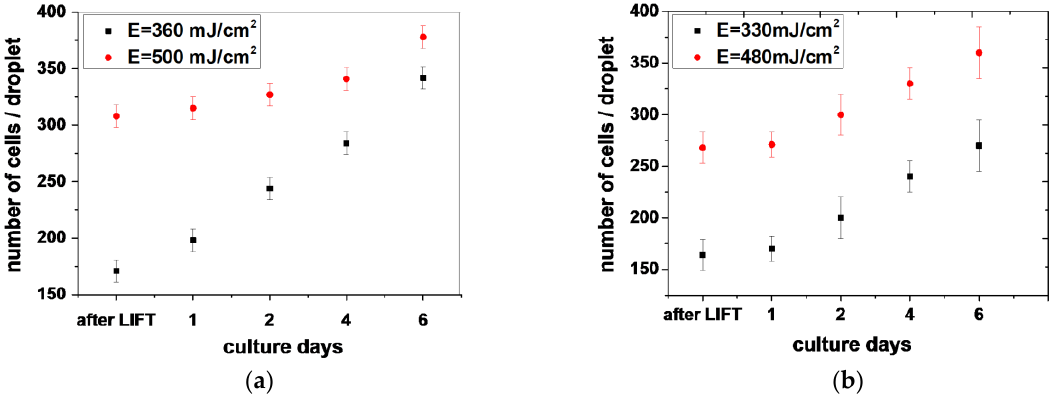
Figure 6. Number of LIFT-printed MDA-MB-468 cells per droplet ( a ) at 532 nm and ( b ) at 355 nm for the indicated laser fluencies. The experiments were conducted at least in triplicates and the number of counted droplets was a minimum of 5 droplets per condition. Error bars indicate SEM.